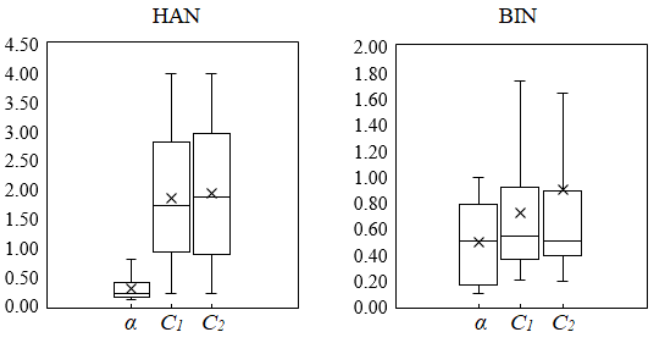
Figure 5. Box and whiskers plots for α , C 1 , and C 2 values for all